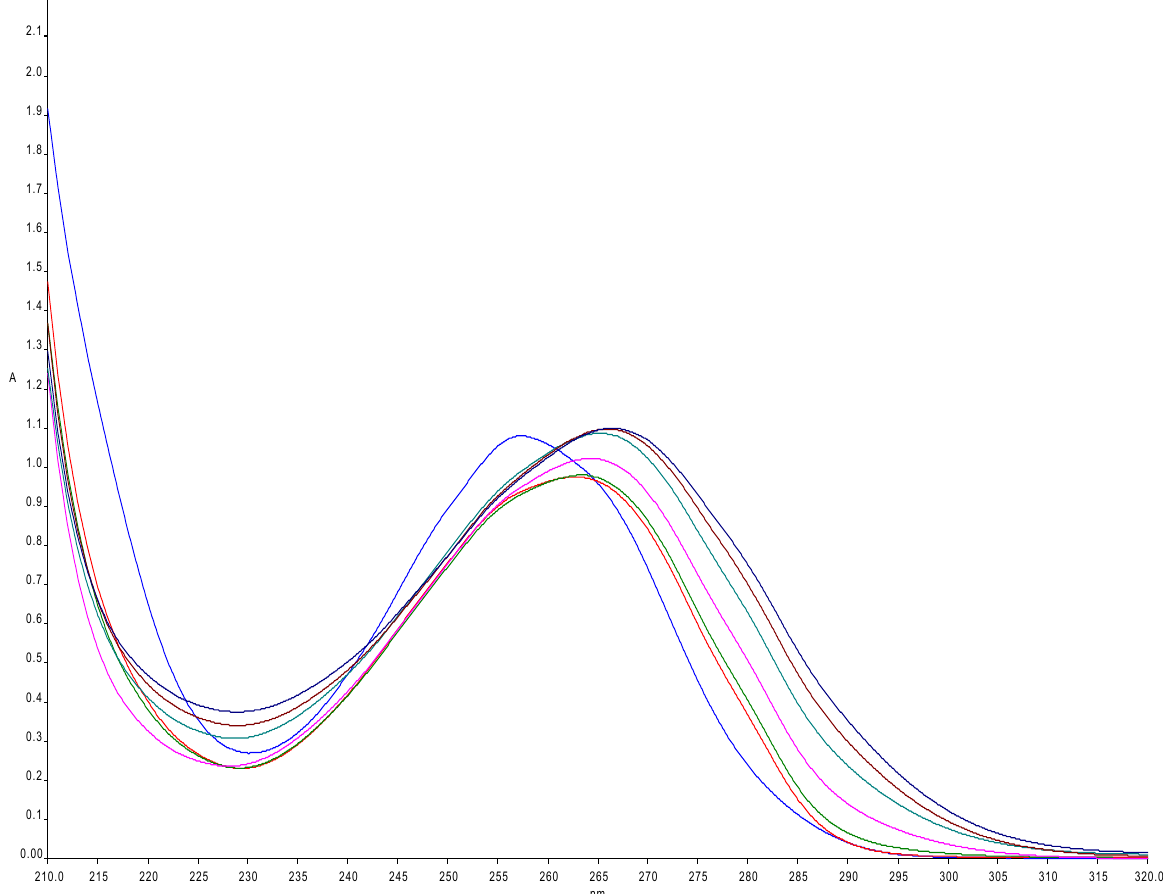
Figure 9: UV-Vis absorption spectra of acidic hydrolysis of AMPNa